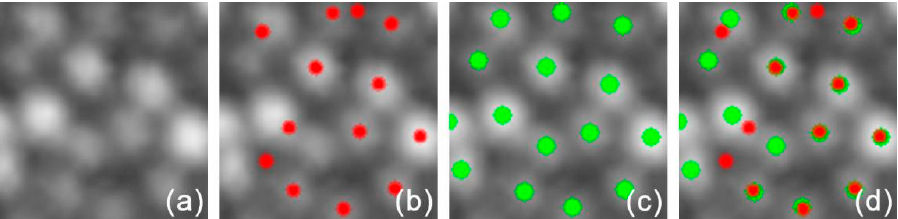
Figure 7. Cone cell dentification based on threshold segmentation. ( a ) Denoised AO-SLO image patch. Identification results from ( b ) the method in Section 2.4 (red dots), ( c ) threshold segmentation (green dots), and ( d ) both methods on the denoised AO-SLO image patch.